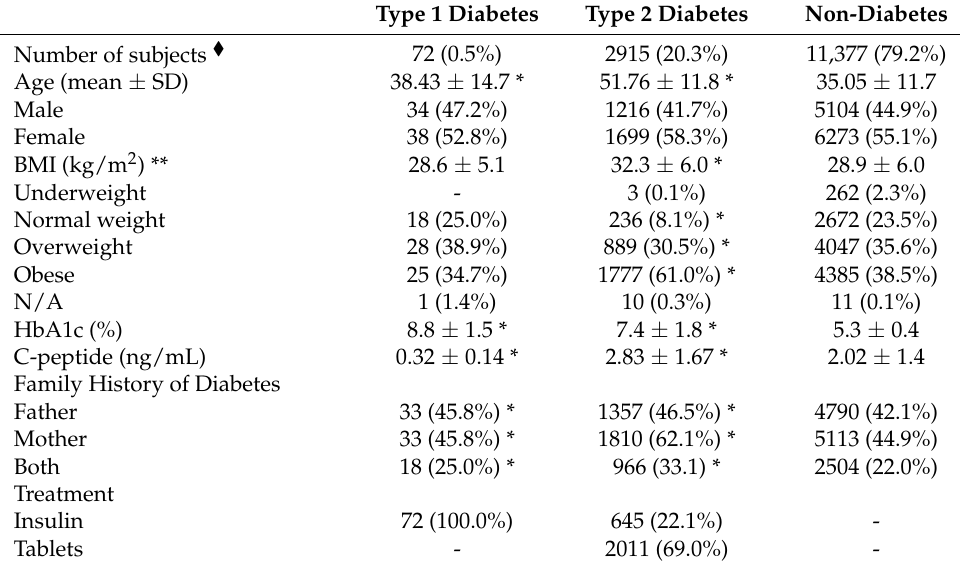
diabetes controls. BMI: body mass index. ** Subjects with BMI below 18.5 kg/m 2 were classified as